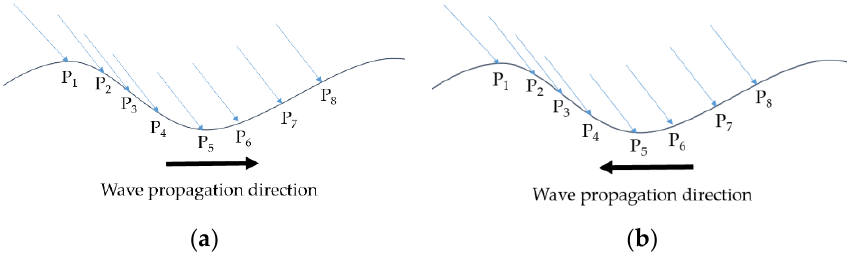
Figure 12. Eight different points of water entry of the boat when the ship is heading the wave ( a ) and following the wave ( b ).